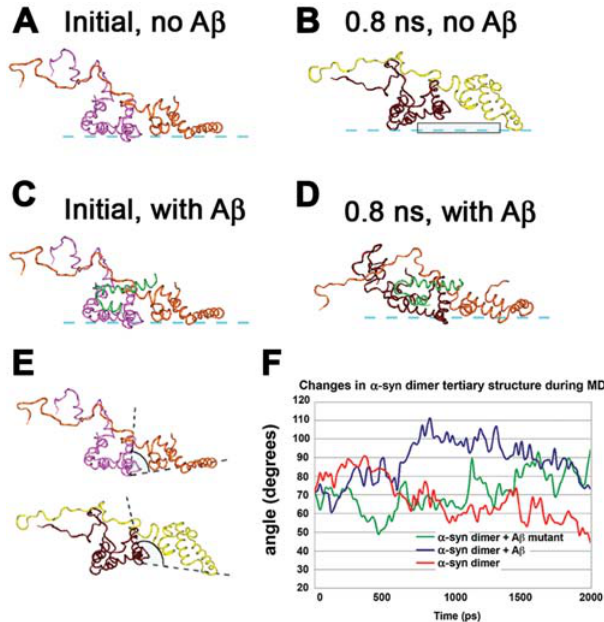
Figure 4. Molecular dynamics of conformational changes of membrane-associated a -syn in the presence of one A b monomer. ( A ) Initial conformation of a -syn dimer on the membrane without A b . ( B ) 0.8 ns conformation of a -syn dimer on the membrane without A b . ( C ) Initial conformation of a -syn dimer on the membrane with A b monomer. ( D ) When complexed with the A b monomer, after 0.8 ns the conformation of the a -syn dimer on the membrane is drawn closer to the membrane, and the a -syn molecules make more contact points with the membrane surface than the a -syn dimer alone. ( E ) Comparison of the two complexes at 0.8 ns demonstrating the angle measured between the C-alpha atoms of the residues VAL66 ( a -syn1), LYS45 ( a -syn1), VAL37 ( a -syn2). The complex without A b had an angle of , 80 u (upper), while the complex with A b had an angle of . 80 u (lower) and was more stable on the membrane. ( F ) Changes in angle measurements in the complexes over time without A b or in the presence of wild-type or mutated full-length A b . In the mutated A b peptide, positively-charged residues were substituted for negative ones and hydrophobic residues for hydrophilic ones (PHE4SER, GLU11ARG, VAL12SER, LYS16ASP).